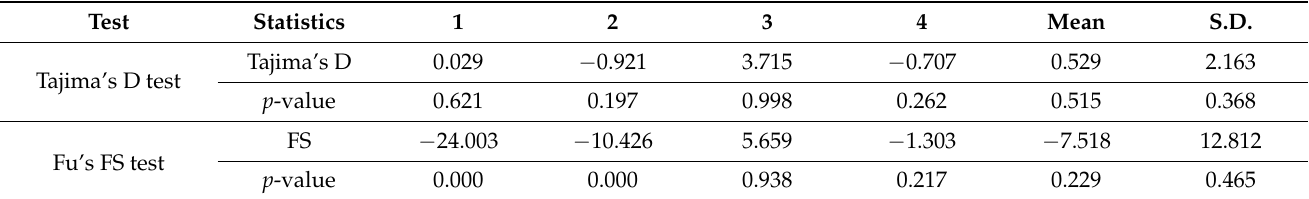
Table 2. A summary of the neutrality test.